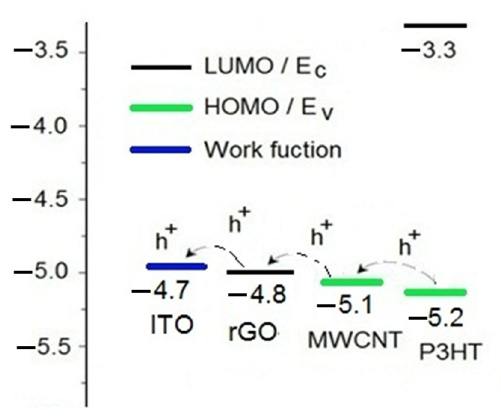
Figure 7. Scheme of the energy levels of single components of the PGC-60 composite sensor. The dashed arrows indicate hole movement directions during the resistance measurement.